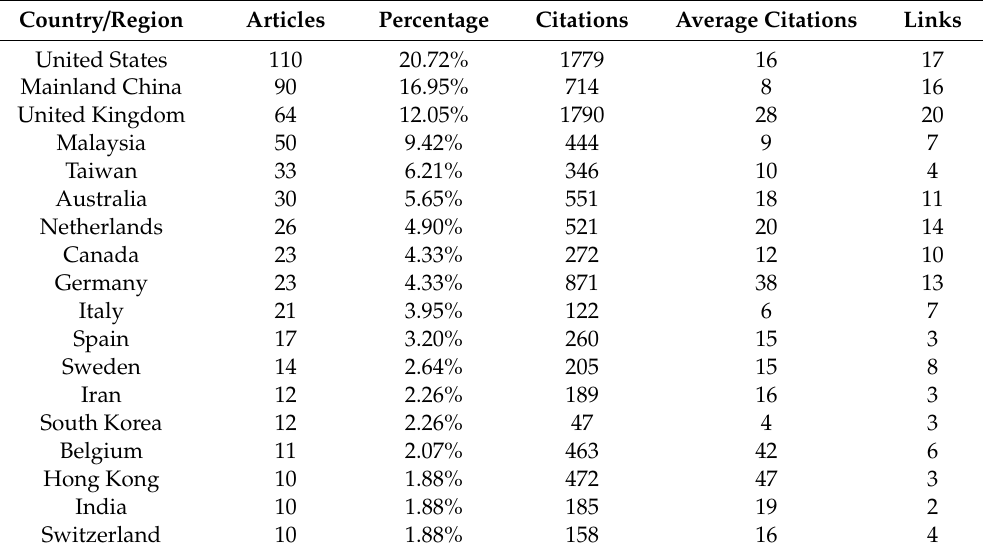
Table 2. Publication characteristics of productive countries and regions.